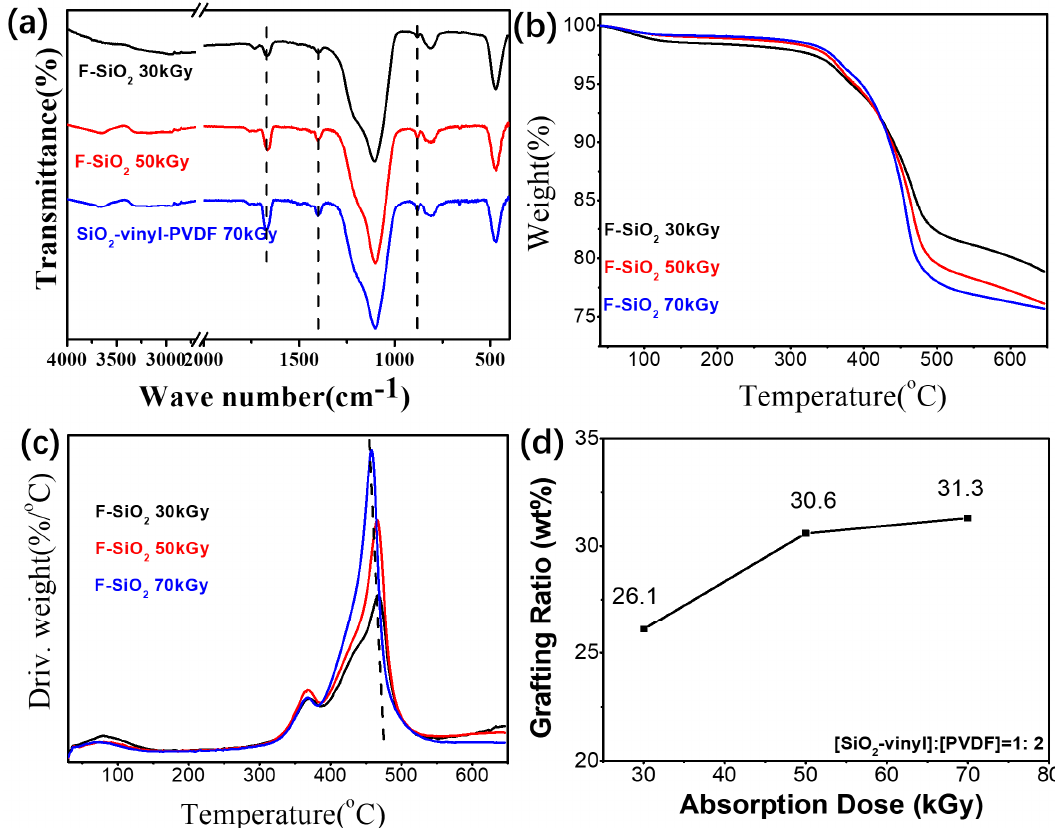
Figure 6. FT-IR ( a ), TGA ( b ), DTG ( c ) and the grafting ratio ( d ) curves of the F-SiO 2 under a di ff erent absorbed dose and a 17-h Gamma-radiation condition. The reactant ratio of [SiO 2 -vinyl]:[PVDF] =